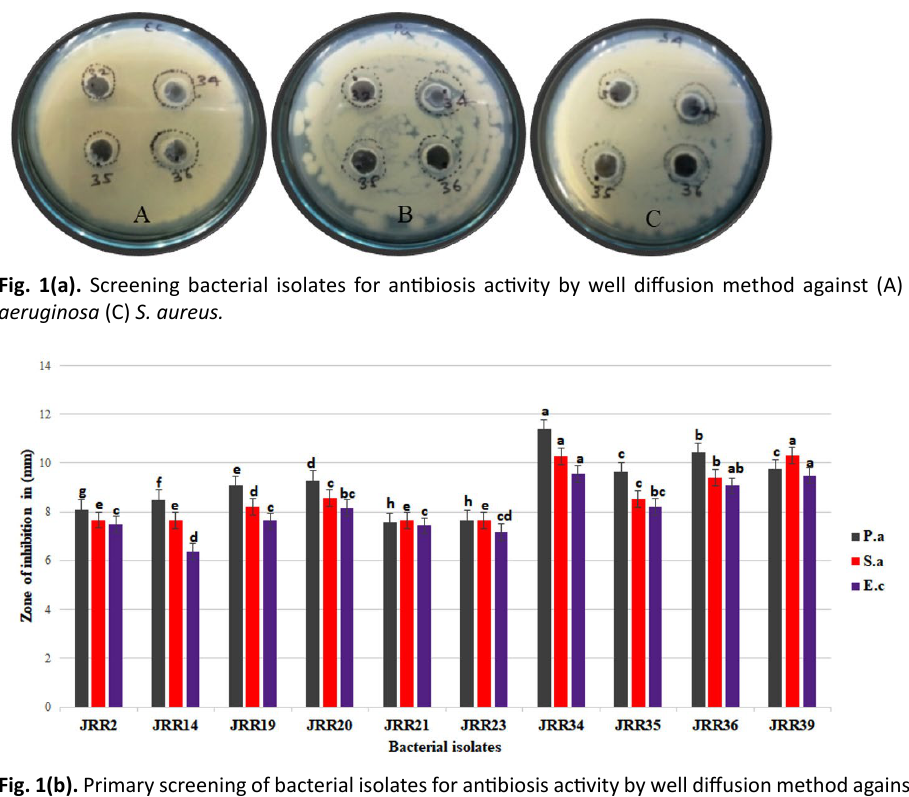
Fig. 1(b). Primary screening of bacterial isolates for antibiosis activity by well diffusion method against pathogenic bacteria P. aeruginosa, S. aureus and E. coli. (Results are expressed as means of three replicates and vertical bars indicate standard deviations of the means. Different letters indicate significant differences among bacterial isolate activity taken for the same bacterium according to Duncan’s multiple range test at P ≤